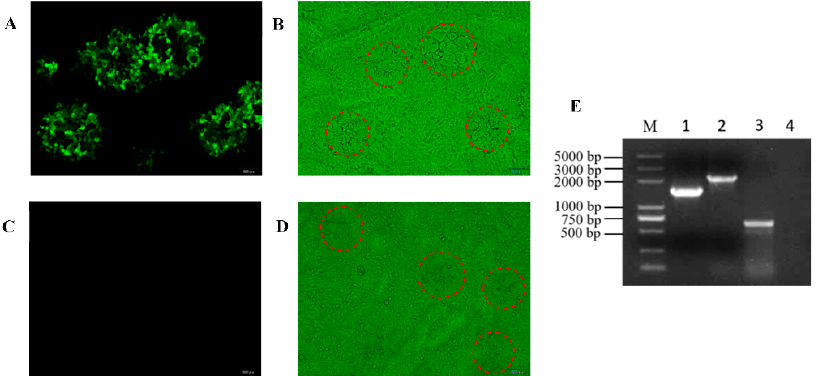
Figure 2. Purification and identification of PRV strains. ( A ) Plaque purification of PRV Δ gE/TK/US3/EGFP + strain for fluorescence visual field. ( B ) Plaque purification of PRV Δ gE/TK/US3/EGFP + strain for bright visual field, red circles represent the plaque of PRV Δ gE/TK/US3/EGFP + . ( C ) Plaque purification of PRV Δ gE/TK/US3 strain for fluorescence visual field. ( D ) Plaque purification of PRV Δ gE/TK/US3 strain for bright visual field, red circles represent the plaque of PRV Δ gE/TK/US3. ( E ) PCR analysis of different PRV strains with primers US3 ‐ F/R. Lane 1, PRV QYY2012; lane 2, PRV Δ gE/TK/US3/EGFP + ; lane 3, PRV Δ gE/TK/US3; lane 4, negative control; M, DL2000 DNA Marker.